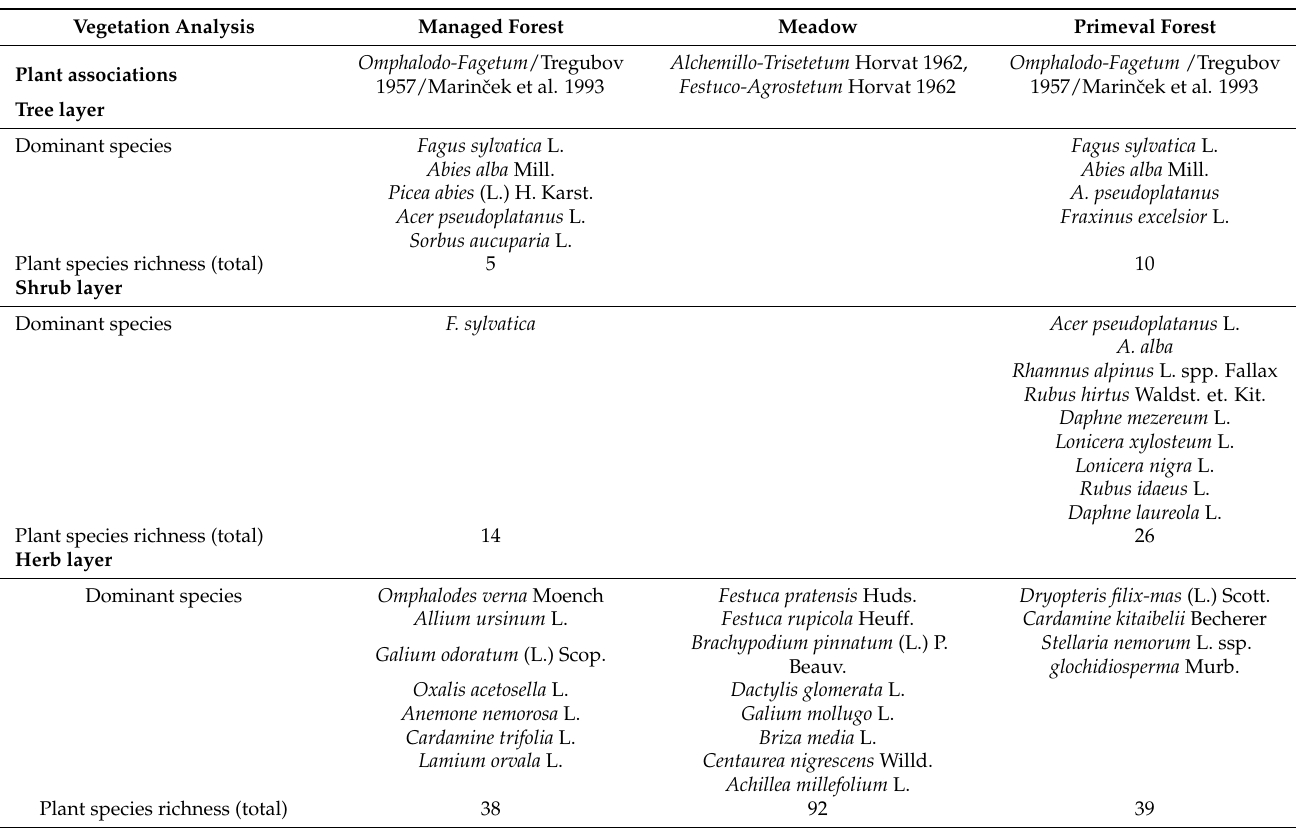
Table 1. Results of the vegetation analysis in the studied habitats in Gorski Kotar and Lika regions (Croatia). Numerical values for plant species richness were obtained from a total of two sites in the managed forest, three sites in the meadow and four sites in the primeval